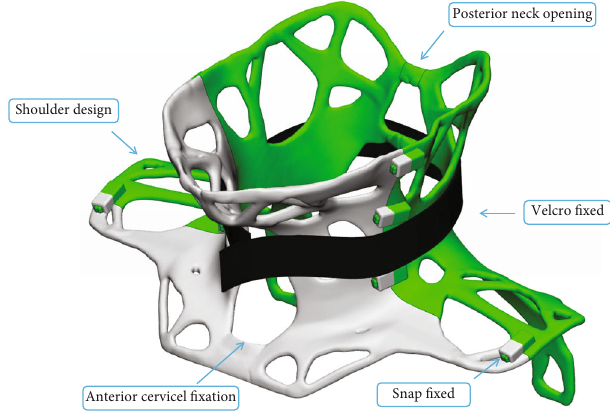
Figure 2: Patient questionnaire chart.